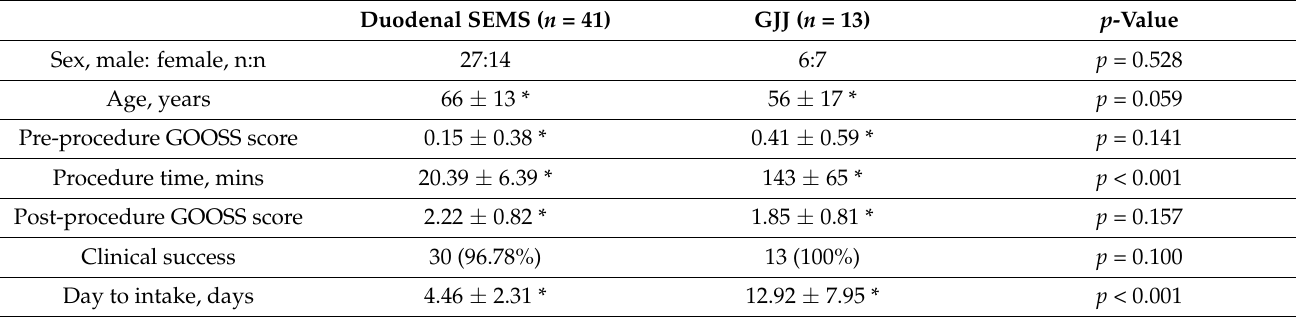
Table 1. Characteristics and outcome of patients underwent treatment of duodenal